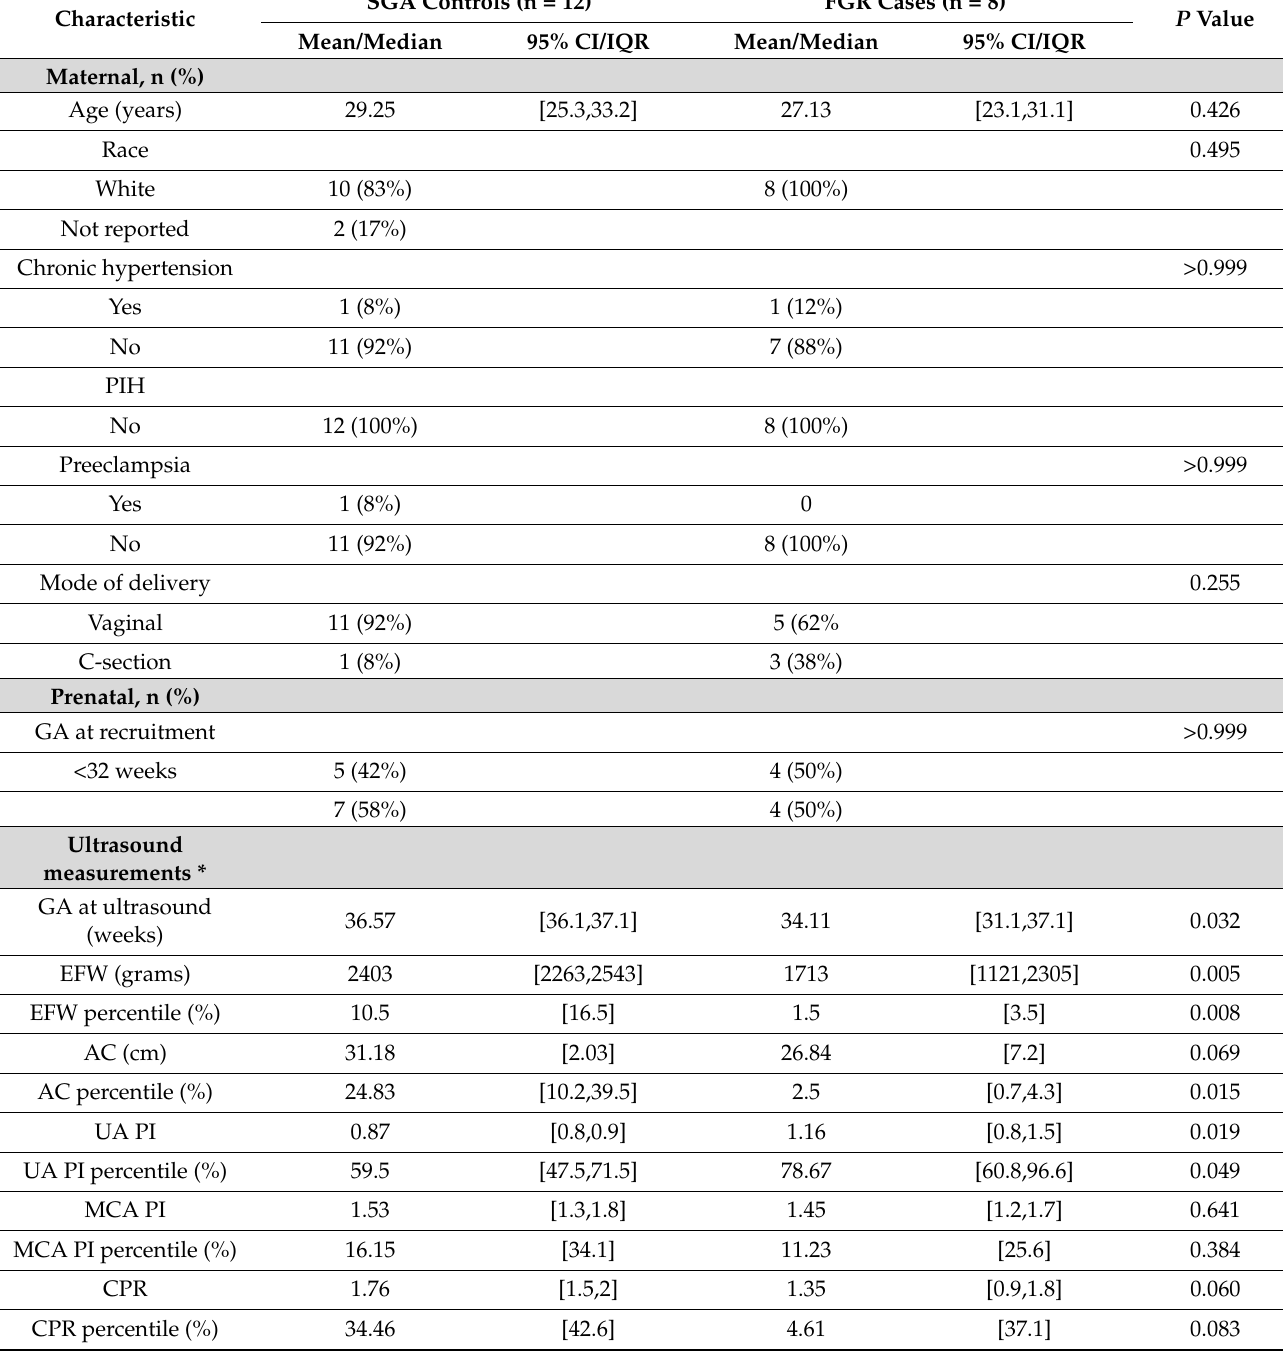
Table 1. Clinical characteristics and ultrasound measurements of SGA Controls and FGR